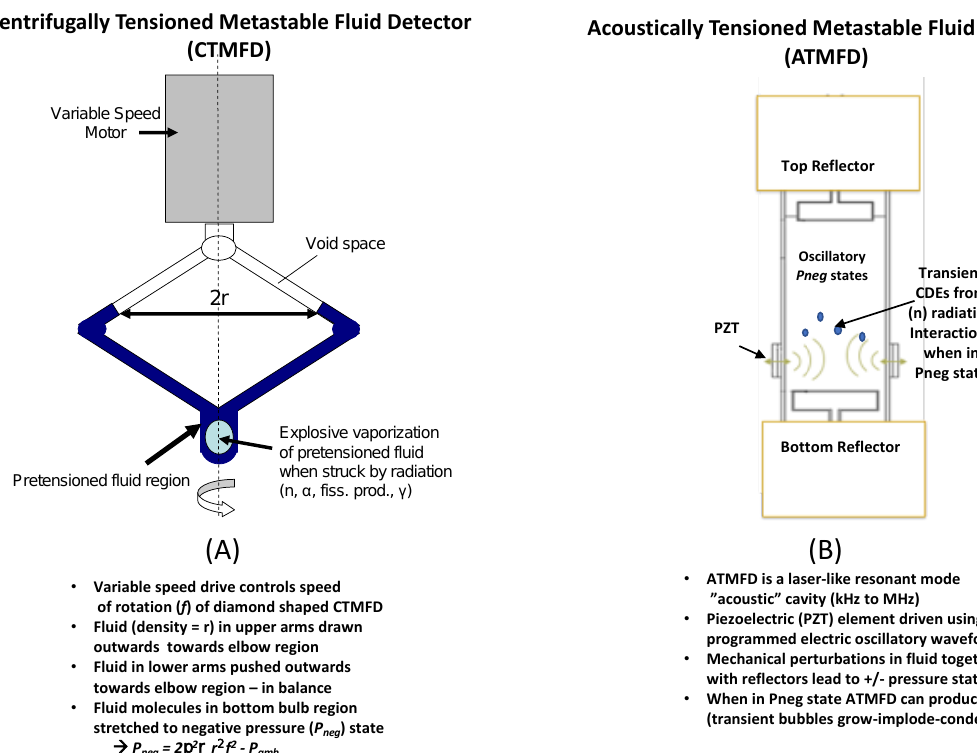
Figure 5. Schematics of CTMFD ( A ) and ATMFD ( B ) sensors and operation basics.